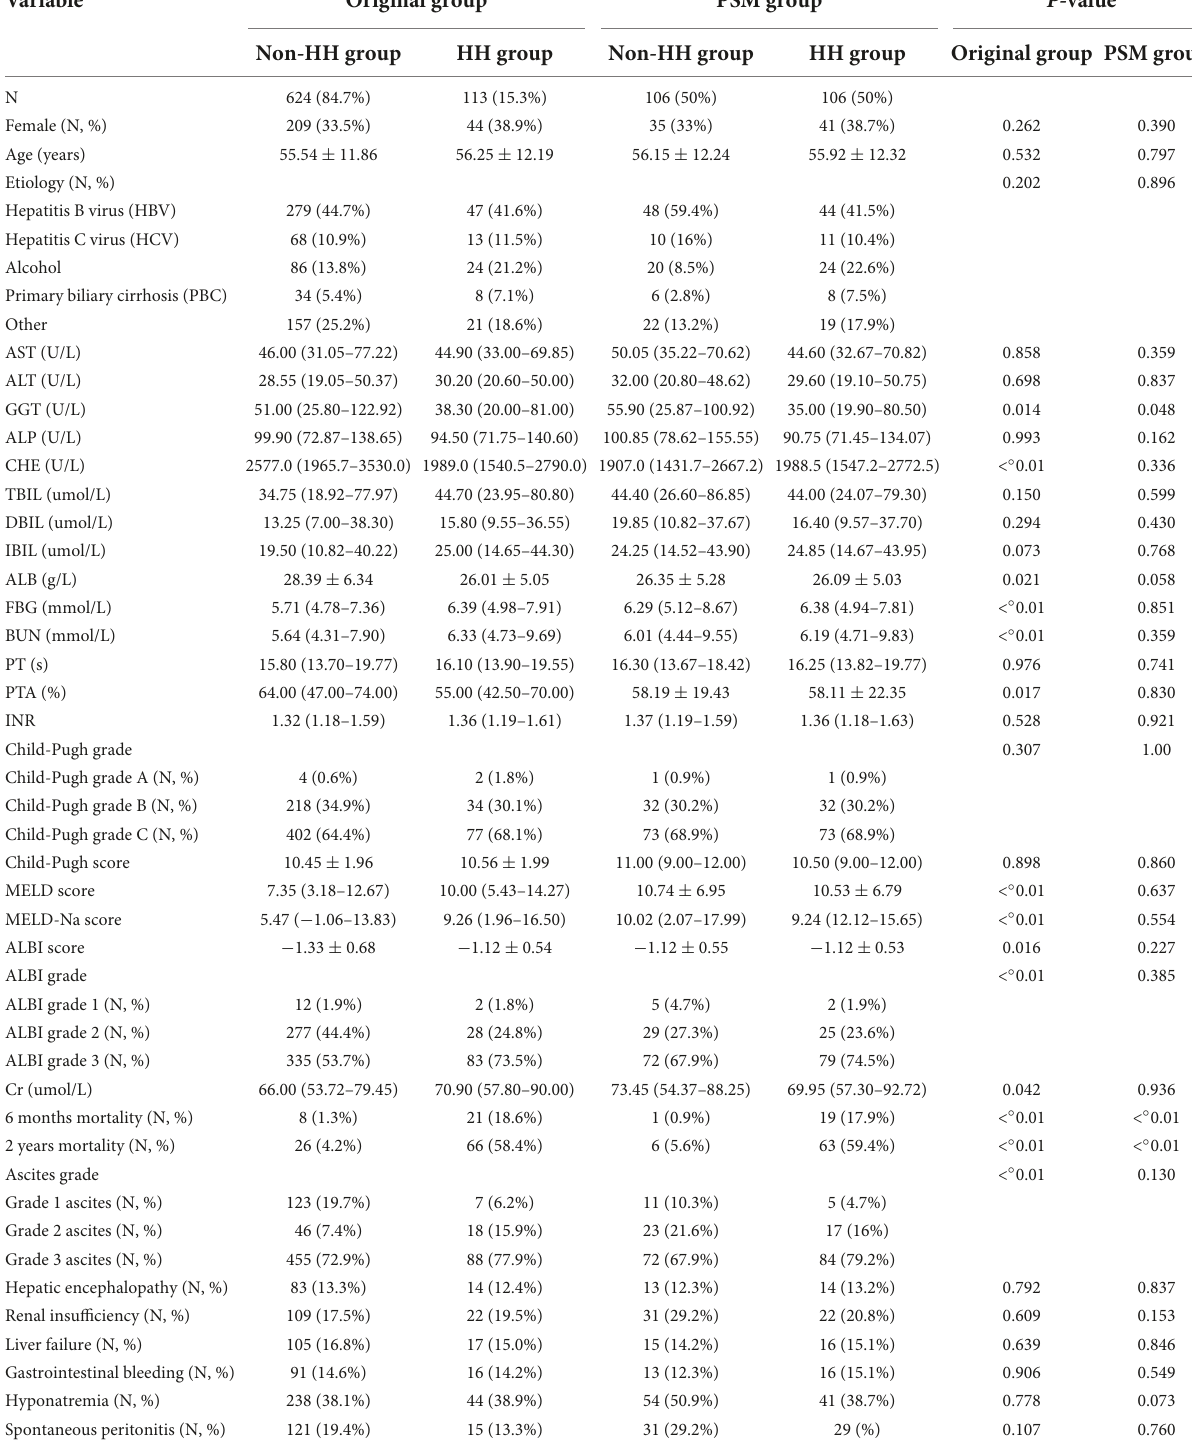
TABLE 1 Comparison of baseline information between patients in the original and propensity score matching (PSM)